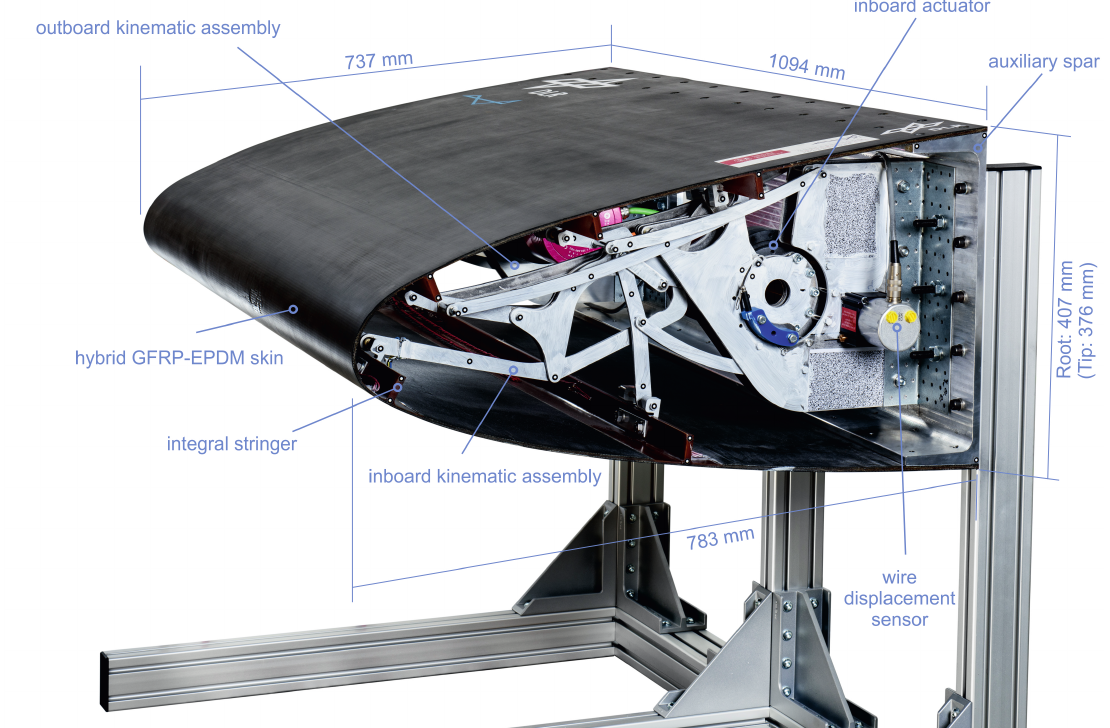
Figure 11. Labelled photograph of the manufactured and assembled demonstrator.